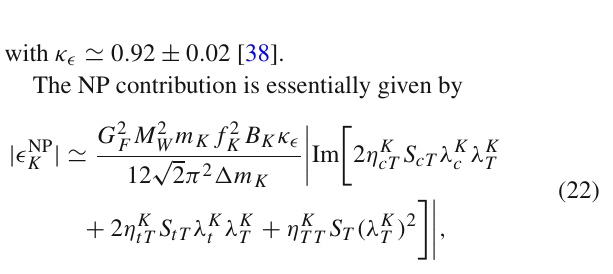
Table 1 Mass and mixing parameters [25] and decay constants and bag parameters [36] for the neutral meson